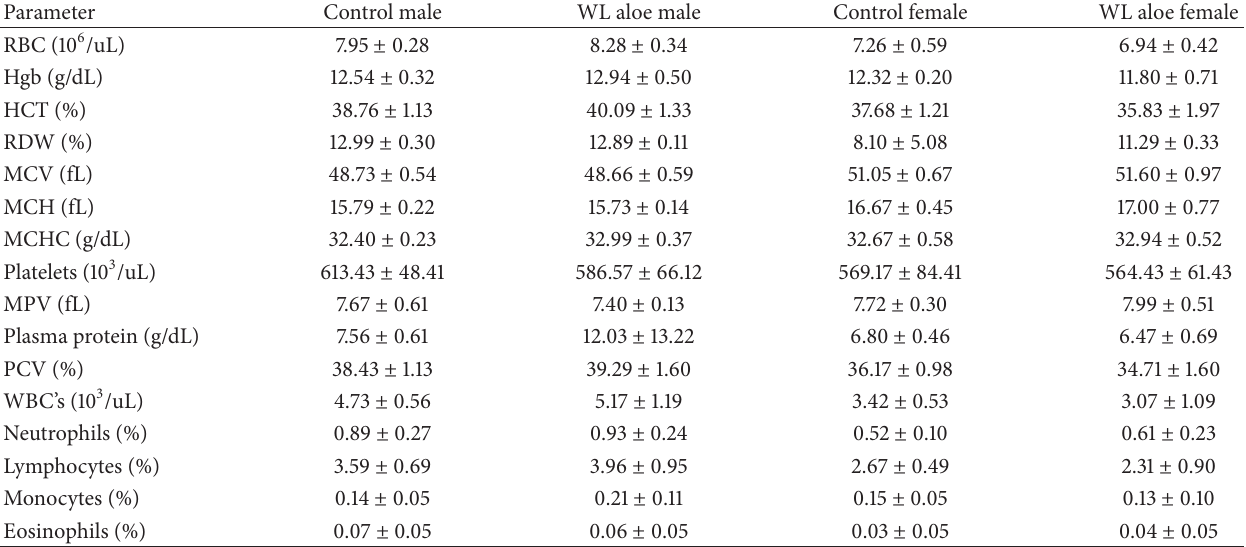
Table 6: The effect of aloe vera administration for 13 weeks on rat